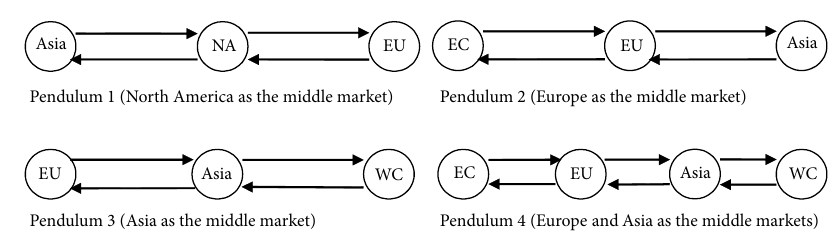
Figure 8. Pendulum models (NA – North America; EU – Europe; WC – West Coast; EC – East Coast)